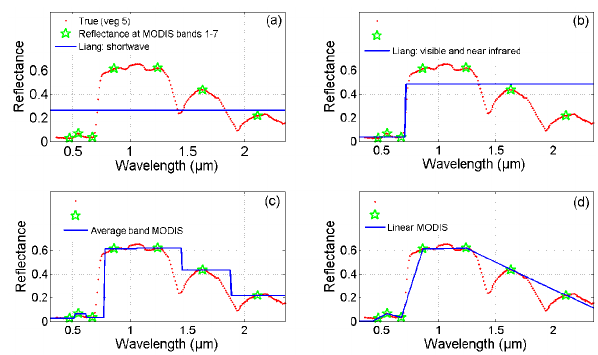
Fig. 2. The x-axis represents the wavelength from 0.3 to 2.35µm la- beled by seven MODIS channels; the dotted red curve is the spectral reflectance for vegetation 5 ( miconia guianensis ) adapted from Arai et al. (2010); the green stars represent the corresponding reflectance at MODIS bands 1–7. In this figure, the spectral reflectance results between 1.35 to 1.45µm and 1.85 to 1.95µm were linearly inter- polated based on Arai et al. (2010) data. These solid red lines are shown as dots in Figs. 3, 5, 6, and 9.